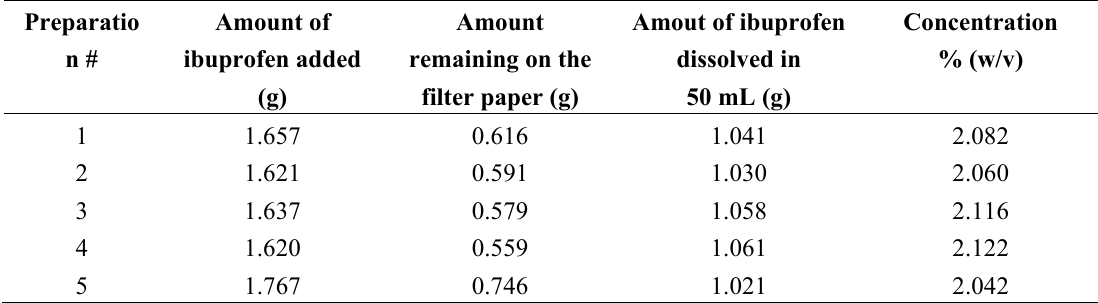
Table 2. A mass balance result (at 60 ºC) for ibuprofen saturated